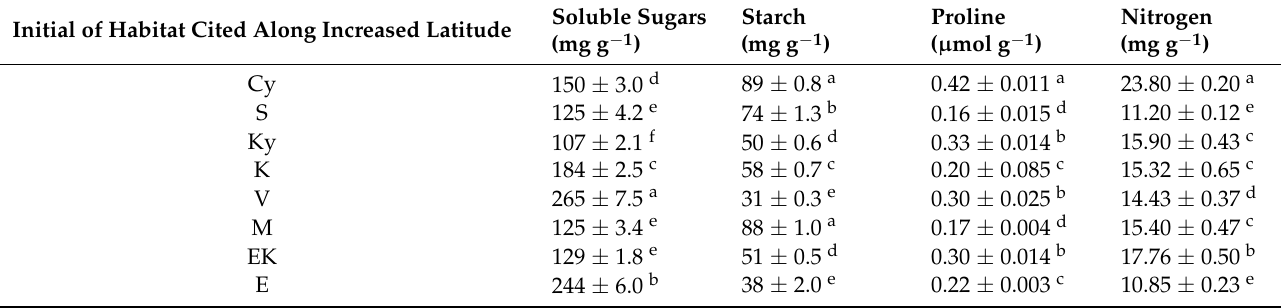
Table 1. Functional traits in pedicels of wild caper fruits. Values are means of five replicates ± standard deviation; significant differences ( p < 0.05) are marked using lowercase superscript letters that are given separately on each column variable. Information about habitat’s initial is given in